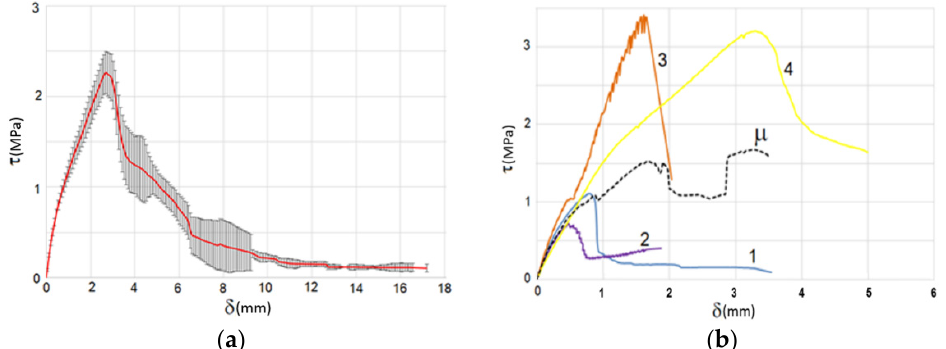
Figure 15. Results of the bonding 2216B/A + BR primer obtained during the shear strength test: ( a ) Samples without aging; ( b ) samples after aging.